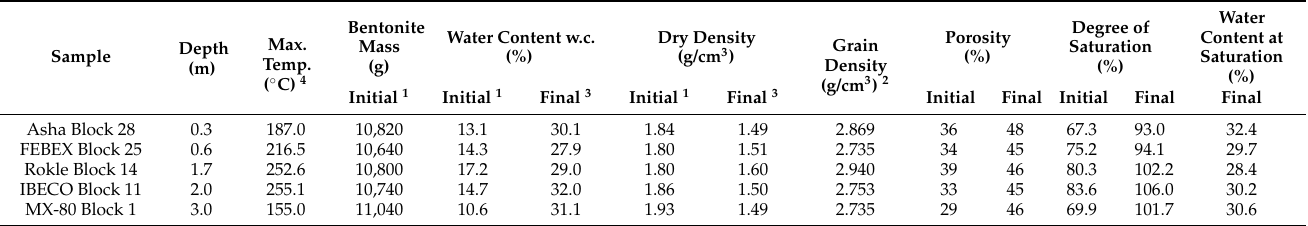
Table 3. Average physical properties from bentonite blocks analysed at CIEMAT prior to (initial) and after 4.4 years of test